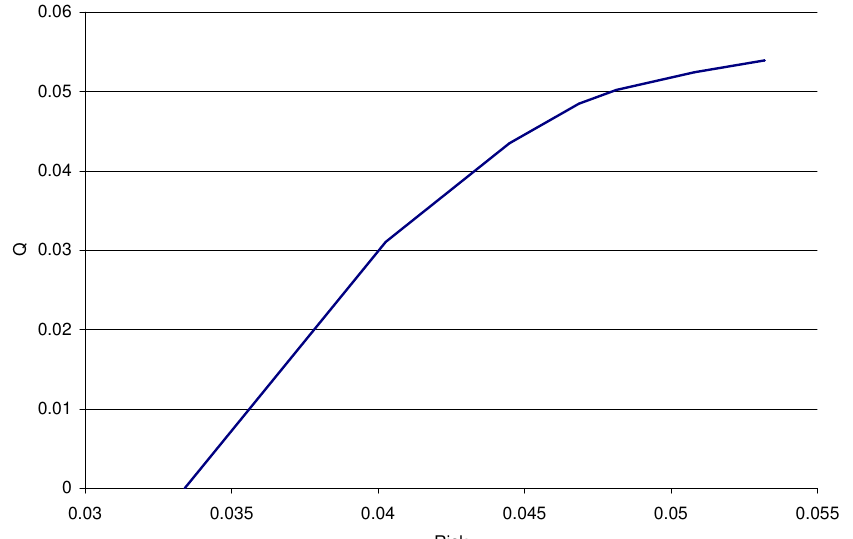
Figure 4: The relationship between Q and risk in solutions to the multiple objective problem (6) with w 1 = 0 . Here Q is the minimum proportion of carrying capacity (food resources) allocated to any species.